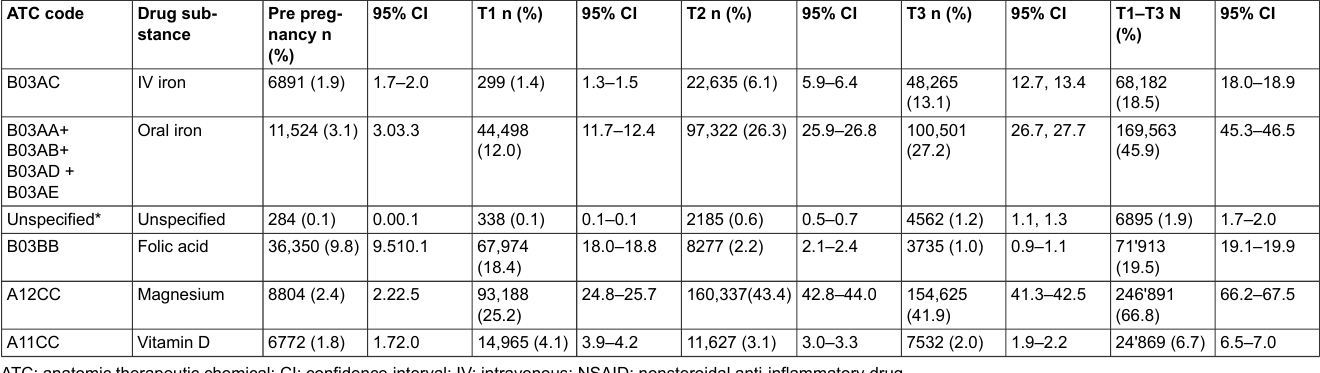
Table 4: Exposure prevalence to supplements (extrapolated numbers). ATC code Drug sub-